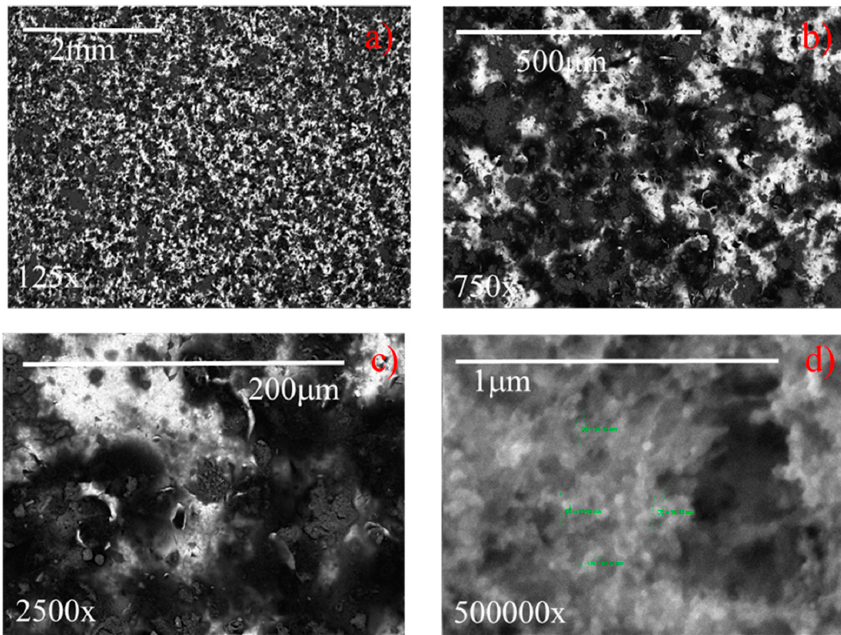
Figure 14. SEM images at different magnifications of a sample having an original roughness of sample 2 ( a ) 125 × , ( b ) 750 × , ( c ) 2500 × , ( d ) 500,000 ×